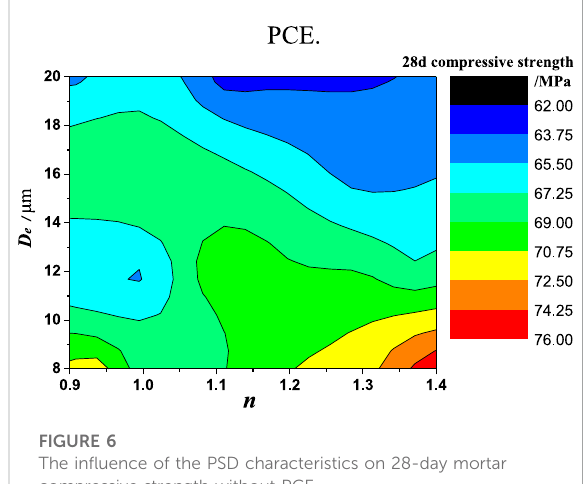
FIGURE 6 The in fl uence of the PSD characteristics on 28-day mortar compressive strength without PCE.